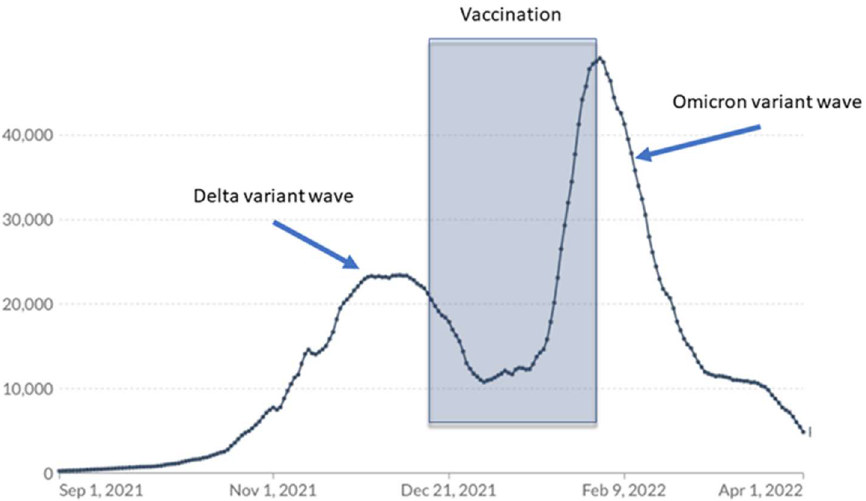
Figure 5. The time patients in the study were vaccinated versus COVID-19 cases reported in Po- land.